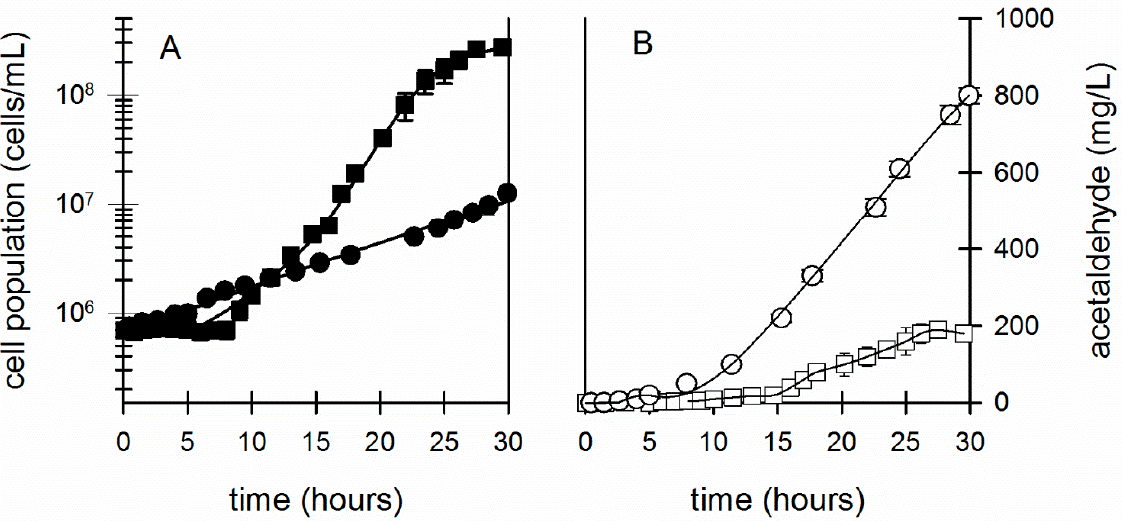
Figure 3. Effect of aerobic culture conditions on the growth of Z. mobilis in medium containing 50 g/L ethanol. (cid:4) , (cid:3) ethanol-stressed culture under anaerobic conditions; (cid:108) , ethanol-stressed culture under aerobic conditions. Closed symbols, cell population; open symbols, acetaldehyde concentration. ( A ) cell populations; ( B ) acetaldehyde concentration. Table 1. Summary of the effects of various metabolic electron acceptors on the growth of ethanol stressed (50 g/L) 1 Z. mobilis.